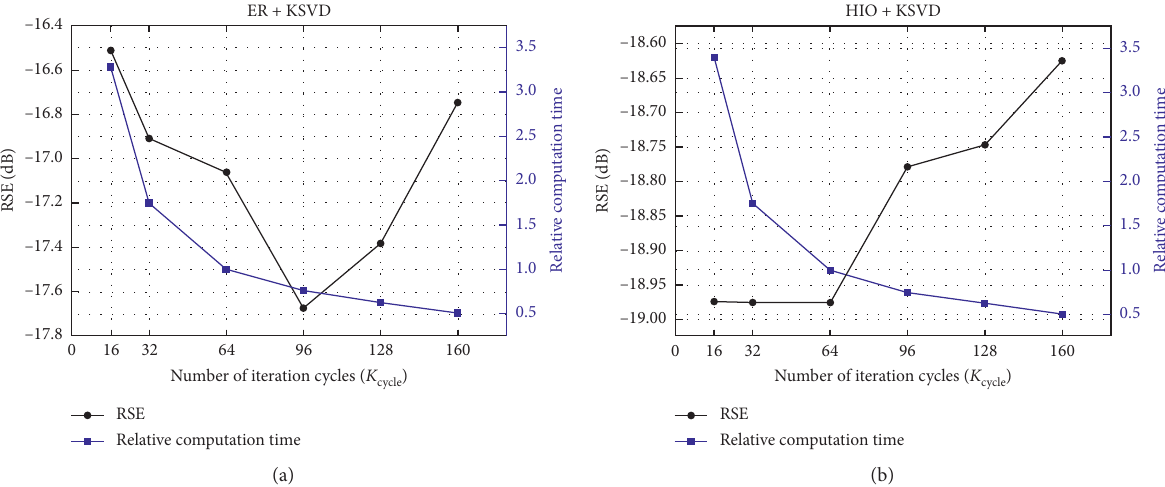
Figure 12: Based on the reconstruction results in Figure 11, the performance of the proposed methods with different iteration cycles K illustrated. Computation time is normalized to the time it takes to use K